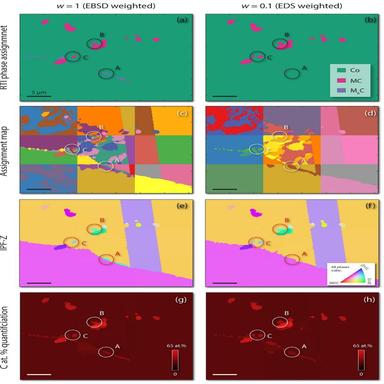
Comparison between phase assignment (a-b), label assignment, with arbitrary colouring (c-d), IPF-Z – out of plane (e-f), and C at.% from the RC-spectra quantified with Bruker eSprit 2.1 (g-h), after processing with w = 1 (EBSD weighted) and w = 0.1 (EDS weighted). Both analyses were performed with a variance tolerance limit t = 0.2%.